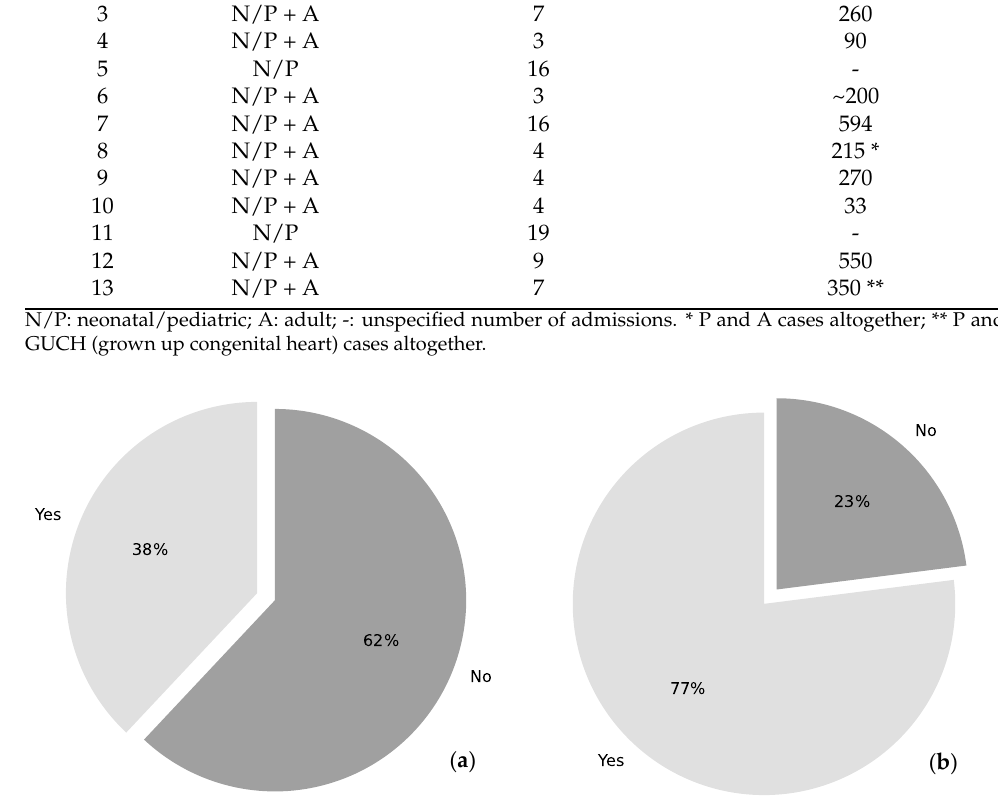
Figure 1A. Presence of a Standardized Protocol for Figure 1B. Presence of a Standardized Protocol for Figure 1. Standardized protocols used in CICUs. ( a ) Presence of a standardized protocol for the the Management of Cardiac Surgical Wound. Monitoring the Cardiac Surgical Wound Infection. management of cardiac surgical wound. ( b ) Presence of a standardized protocol for monitoring the cardiac surgical wound